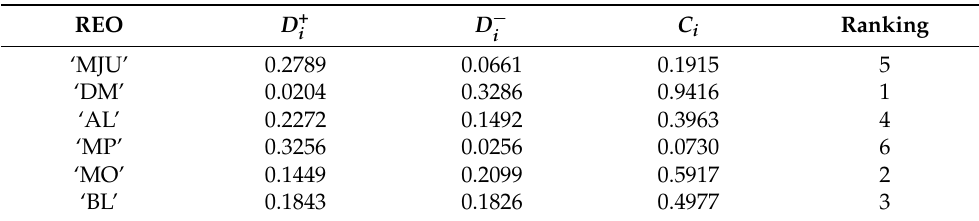
Table 2. TOPSIS Analysis Results and Ranking of